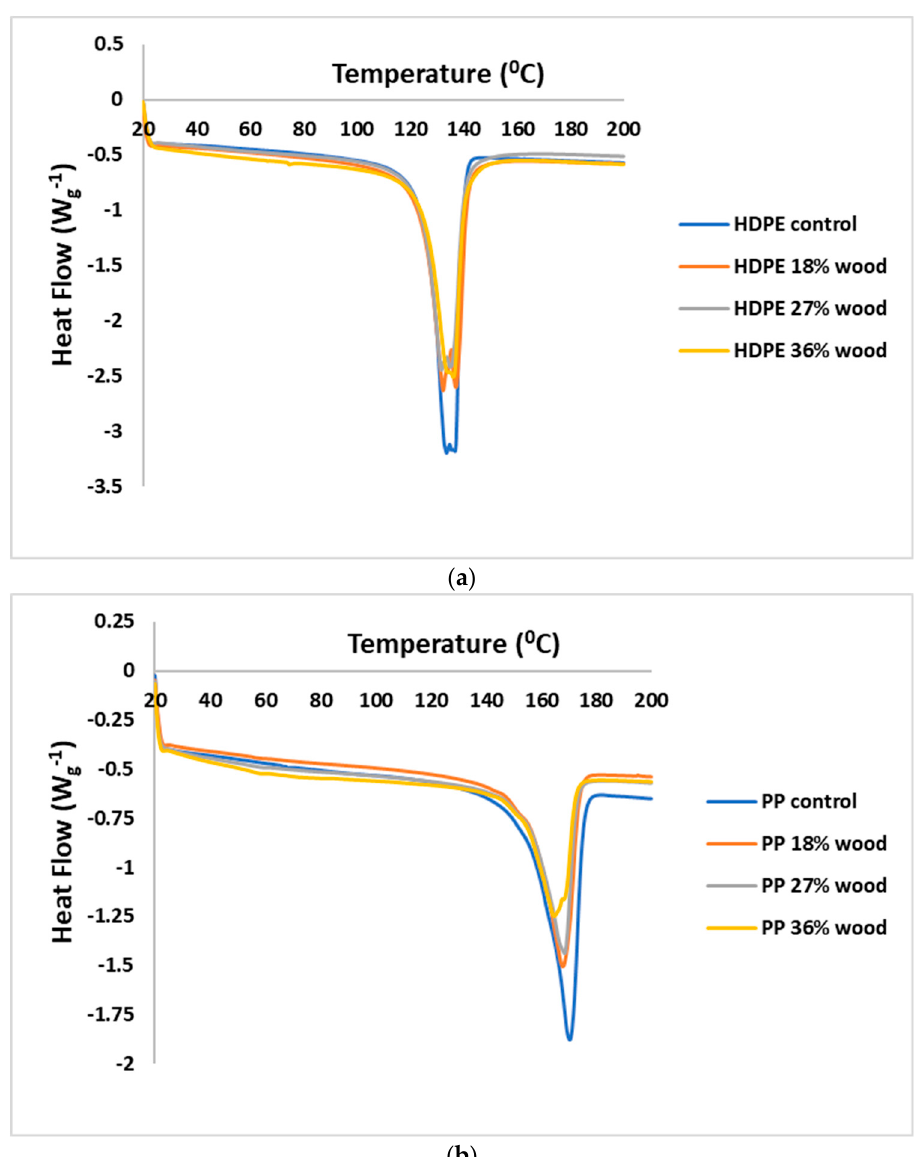
Figure 2. Di ff erential scanning calorimetry of the ( a ) HDPE wood composite and ( b ) PP wood composite samples with di ff erent percentage weight of fi ller, shown as an overlay to illustrate the lack of any signi fi cant di ff erence in the crystalline melt temperatures.